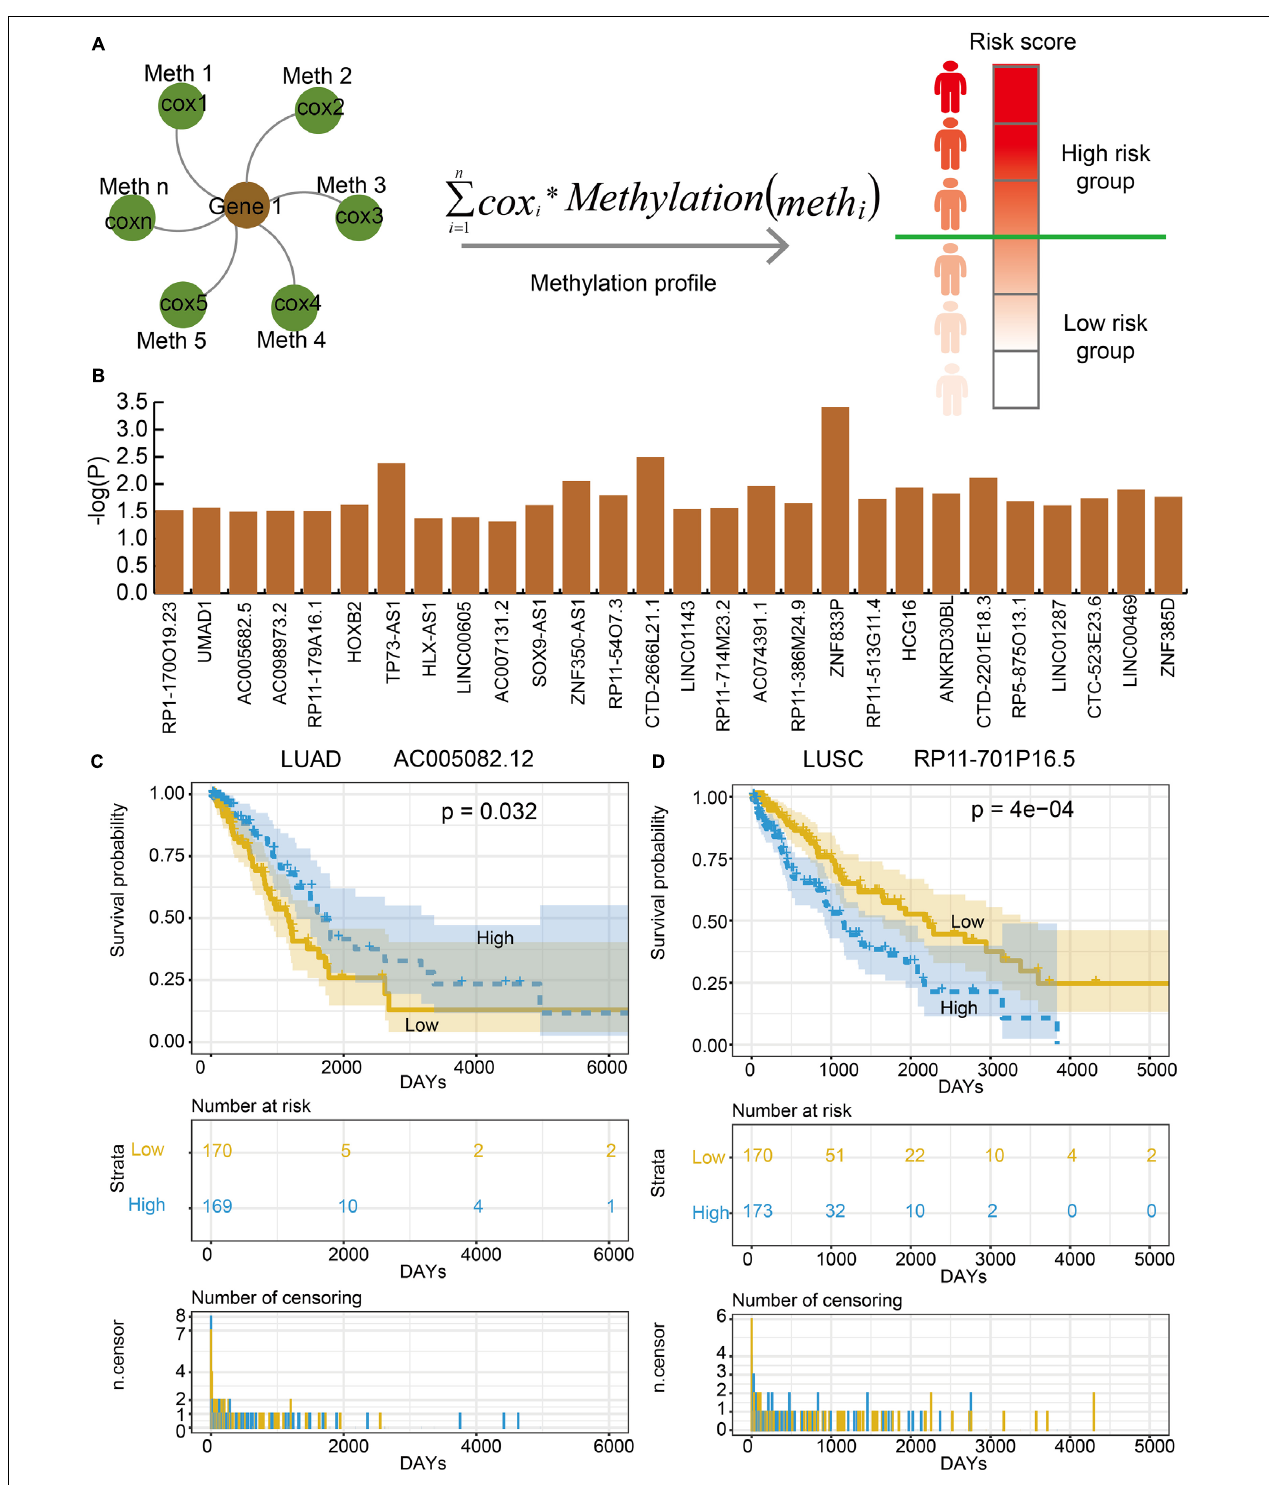
FIGURE 4 | Some lnc-eQTMs were associated with LUAD and LUSC patients’ survival. (A) An integrated model for identifying prognosis-related lnc-eQTMs. Firstly, a multivariate Cox regression model was established for the methylations related to the same DMSmlncRNA in a specific lnc-eQTM. Secondly, the integrated risk score for each lung cancer patient was calculated according to the linear combination of the lncRNA expression values weighted by the coefficient from multivariate Cox regression analysis. Thirdly, all the patients were divided to high- and low-risk group for follow survival analysis. (B) The P -values of prognosis-related lnc-eQTMs in LUSC. (C) Survival curves of AC005082.12 in LUAD. (D) Survival curves of RP11-701P16.5 in LUSC.